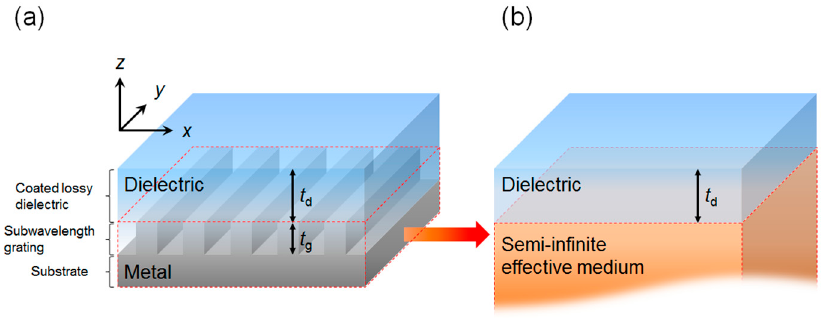
Figure 1. ( a ) A subwavelength metallic grating coated with a dielectric layer. The thicknesses of the upper dielectric layer and grating are t d and t g , respectively. ( b ) The optically equivalent model, in which the grating and substrate are replaced by a semi-infinite effective medium.